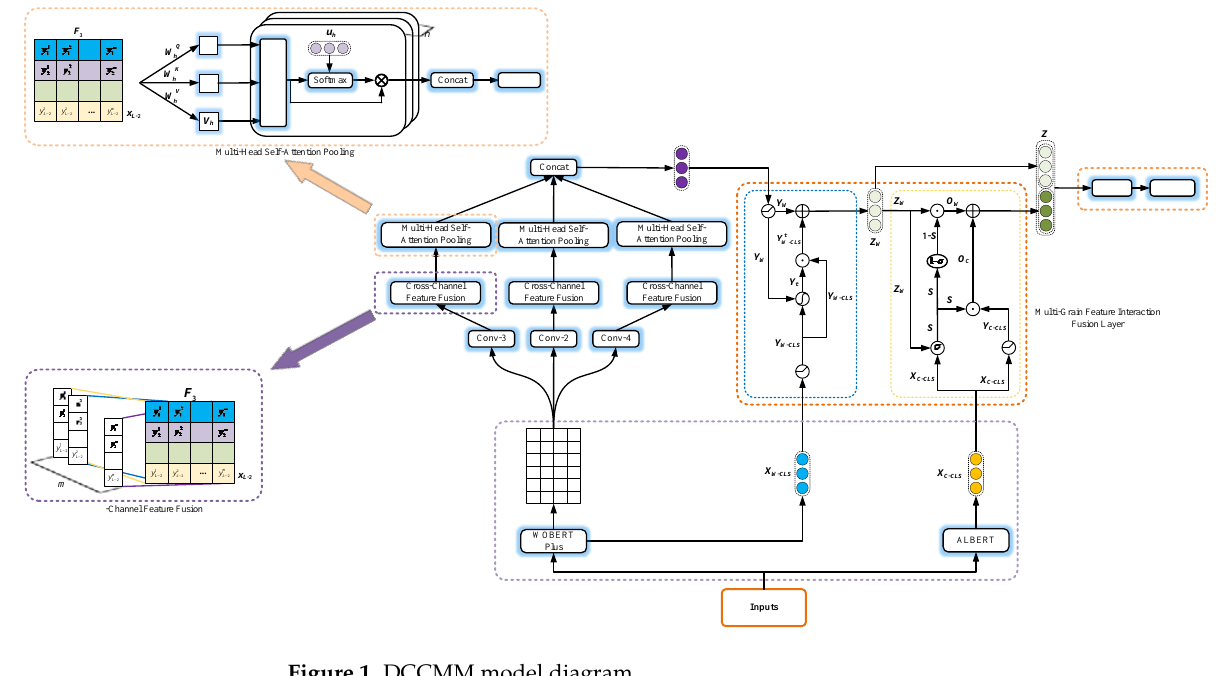
Figure 1. DCCMM model diagram